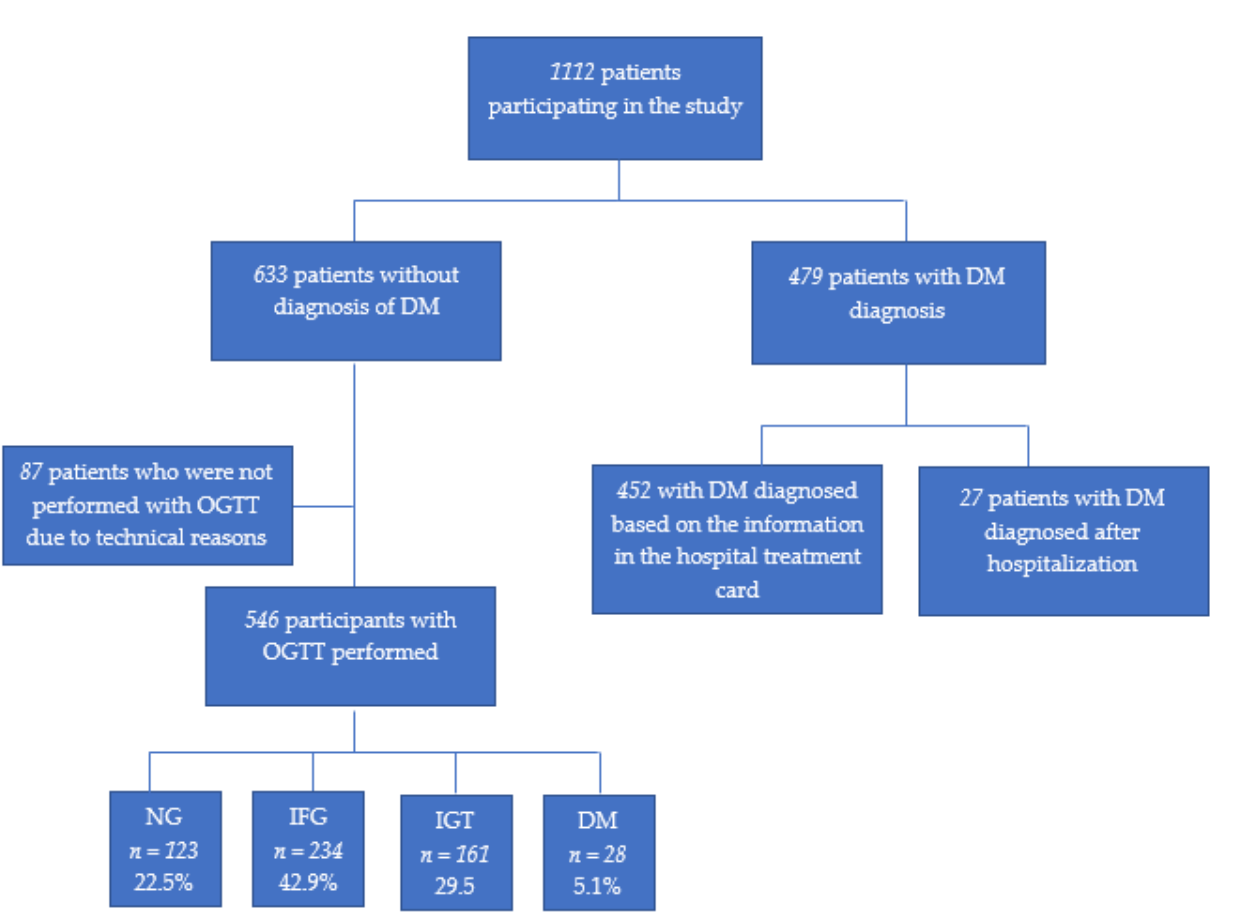
Figure 1. The division of participants into groups.